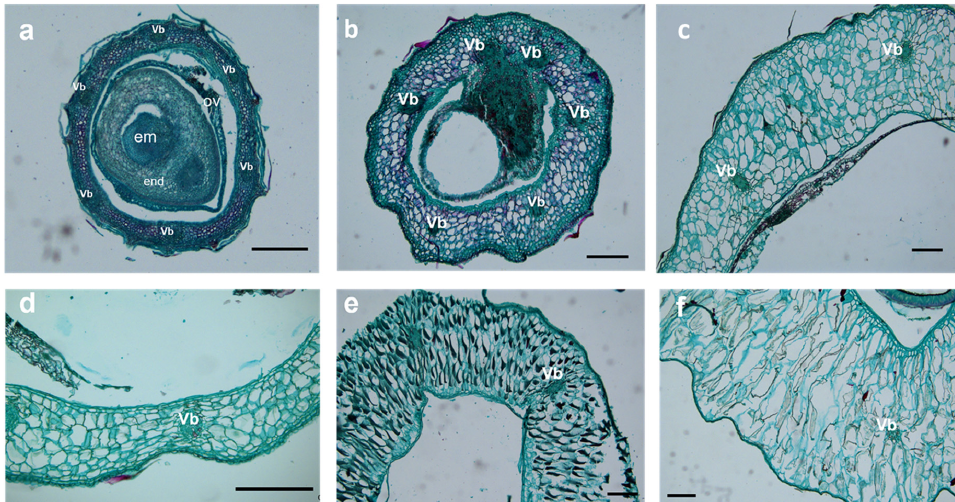
Figure 7. LM micrographs show transversal sections of H. goniocarpa fruit throughout six stages (10 DAA–120 DAA) of growth and development. ( a ) Cellular structure at 10 DAA. Six vascular bundles were arranged circularly on the side of mesocarp cells; ( b ) Cellular structure at 30 DAA; ( c ) Cellular structure at 50 DAA; ( d ) Cellular structure at 70 DAA; ( e ) Cellular structure at 90 DAA; ( f ) Cellular structure at 120 DAA. Bars = 250 µ m. Vb Vascular bundle; Ov Ovary; End endosperm; Em